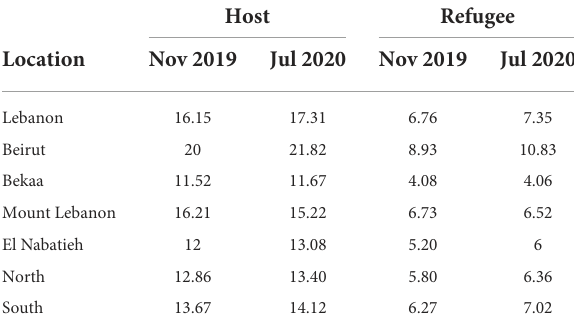
based on the 2020 VASyR report (UNHCR et al., 2020) the TABLE 2 The percentage of iOS users for the host and refugee Facebook users in 2019 and 2020 for Lebanon and its